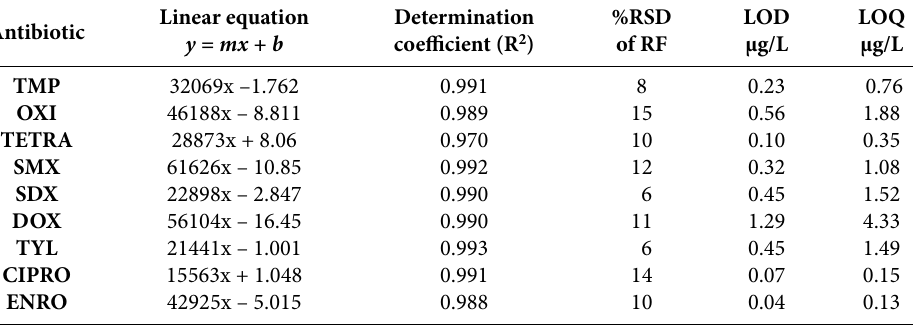
Table 1. Validation parameters of the method used for the analysis of the antibiotics in water.